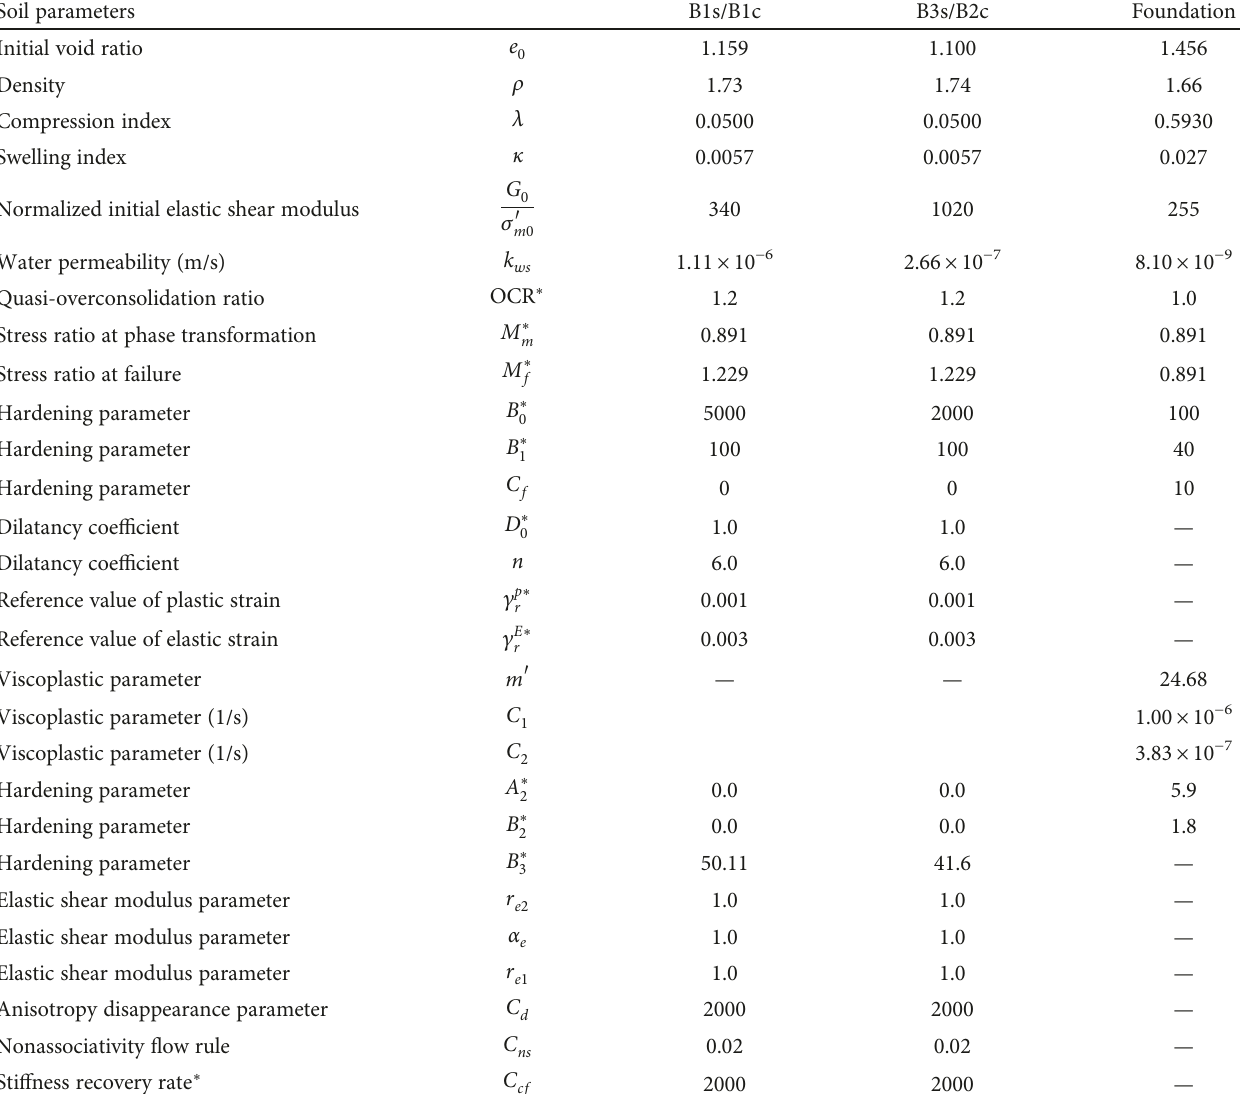
Table 2: Soil parameters for damaged river